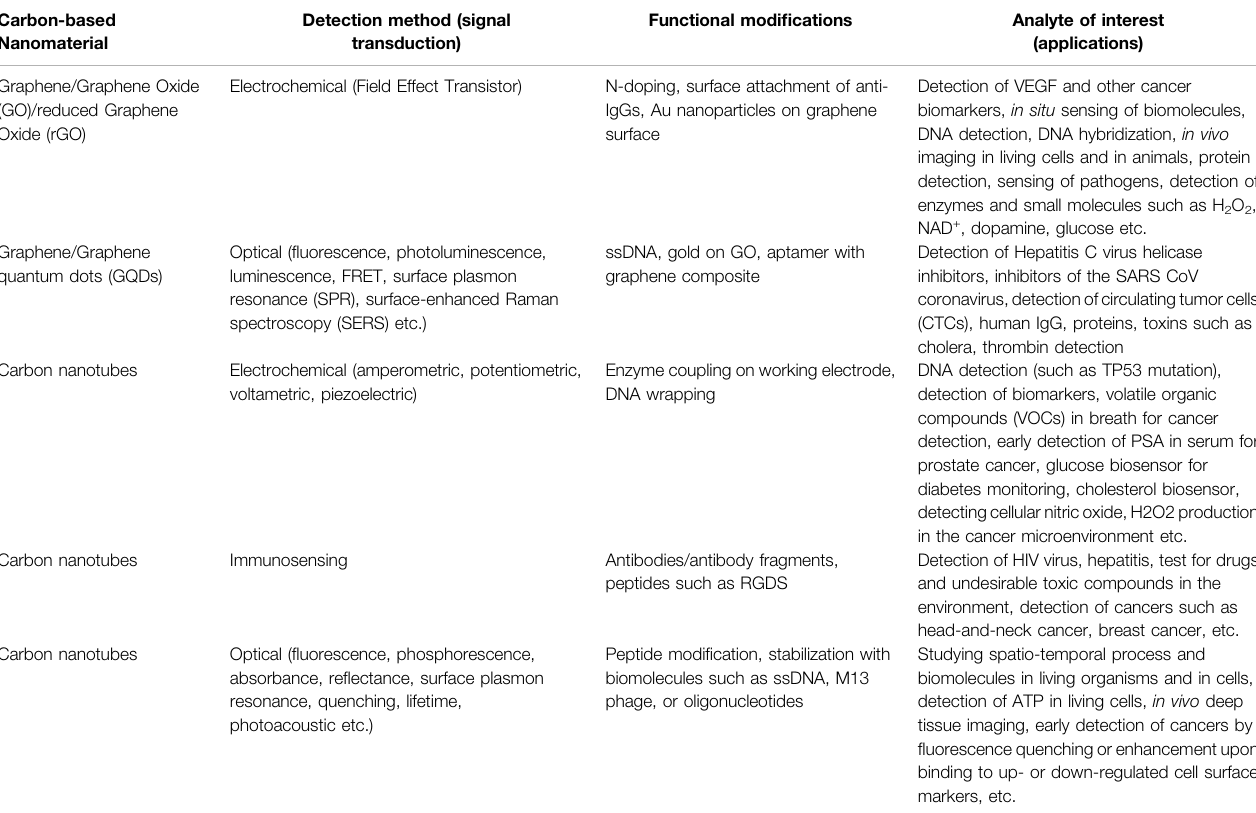
TABLE 1 | Graphene and its derivative carbon-based nanomaterials: representative applications in nanobiosensing. Carbon-based